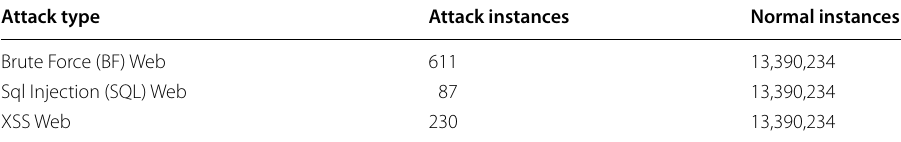
Table 2 Web attacks used in this experiment from